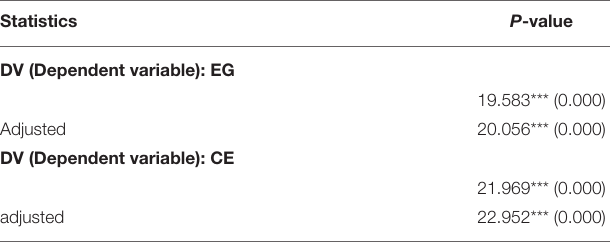
TABLE 4 | Results of slope heterogeneity test.